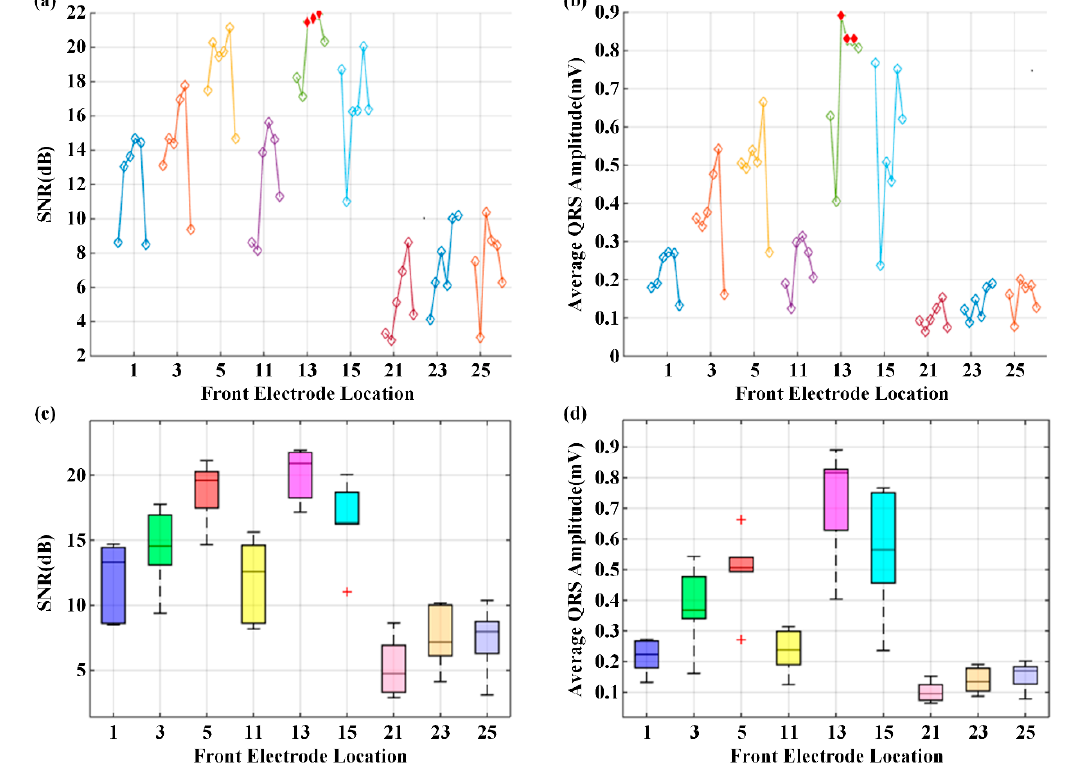
Figure 12. The results of region of interest (ROI) determination: ( a ) Signal-to-noise ratio (SNR) of six channels; ( b ) Average QRS amplitude of six channels; ( c ) SNR distribution of coarse-grained squares; ( d ) QRS amplitude distribution of coarse-grained squares.